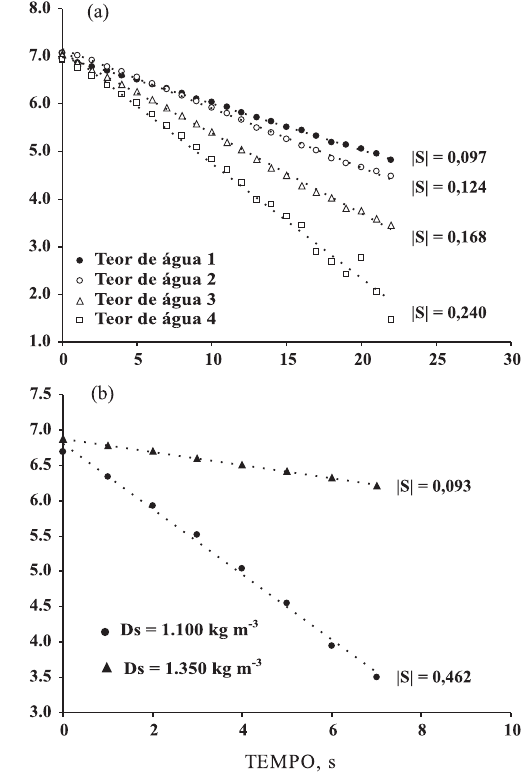
Figura 4. Influência do teor de água (a) e da densidade do solo (b) na variação do